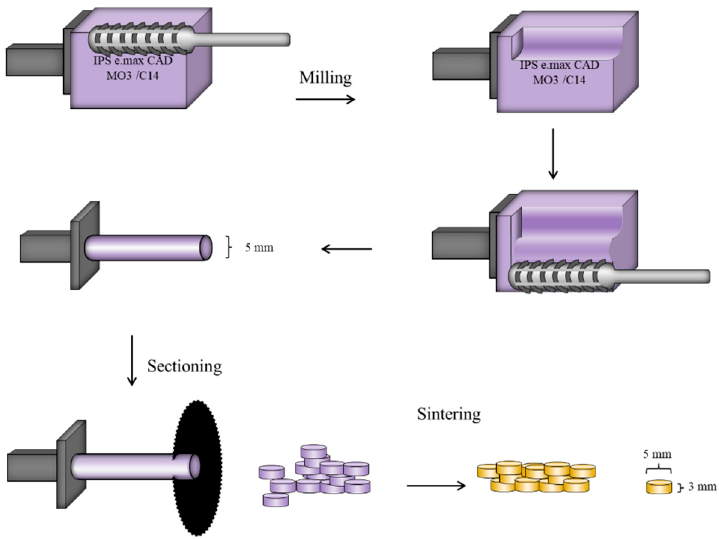
Figure 4. Schematic diagram showing the detailed steps of preparation of IPS e.max CAD lithium disilicate specimens.